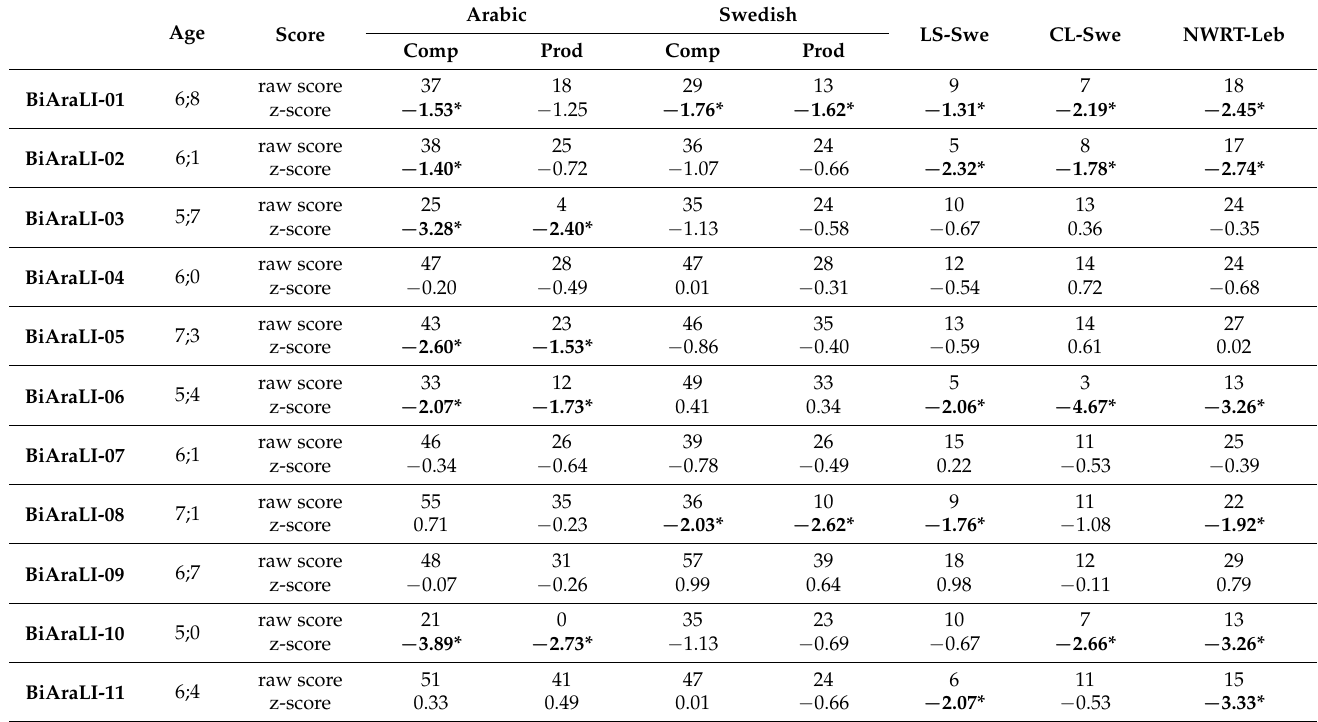
Table 11. Vocabulary comprehension (comp), vocabulary production (prod), and NWR scores (raw scores and age-adjusted z-scores) for children in the DLD